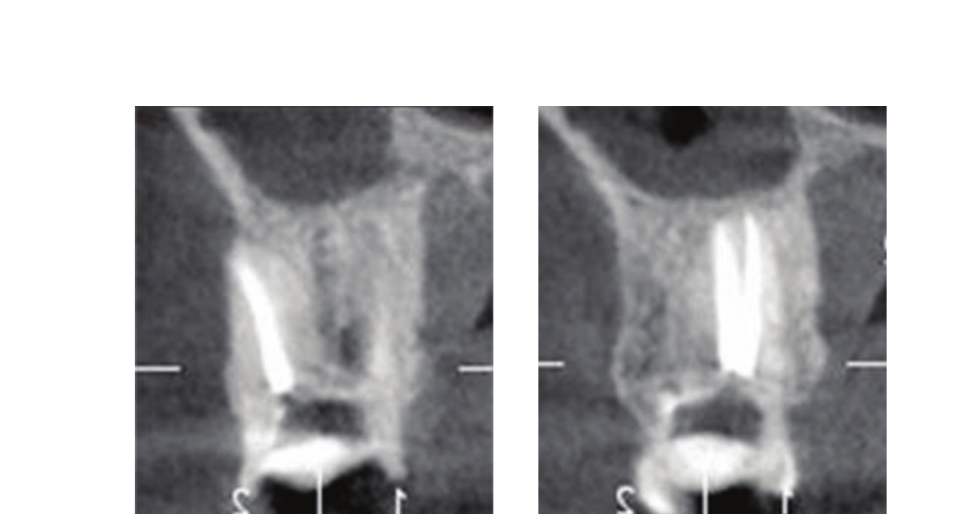
Figure 5: CBCT evaluation.